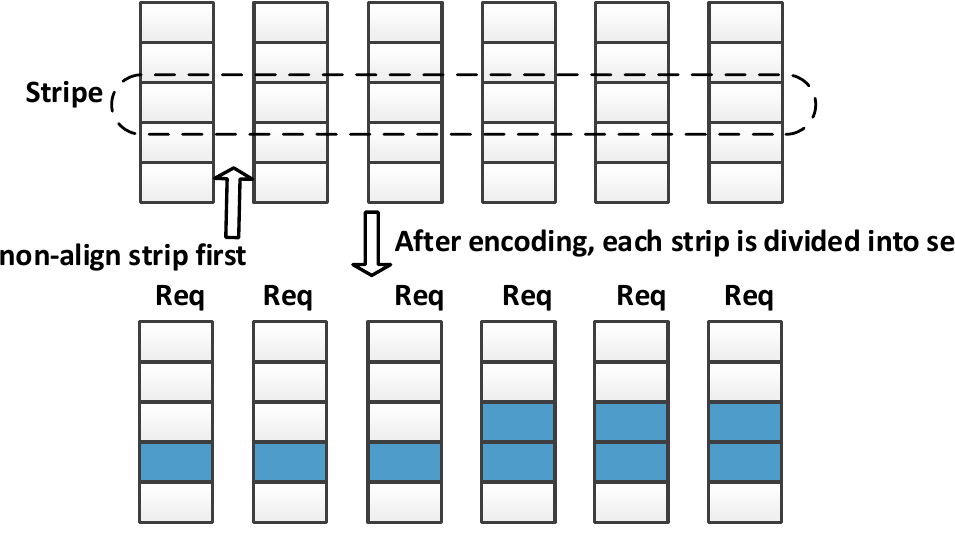
Figure 5. The non-aligned request.